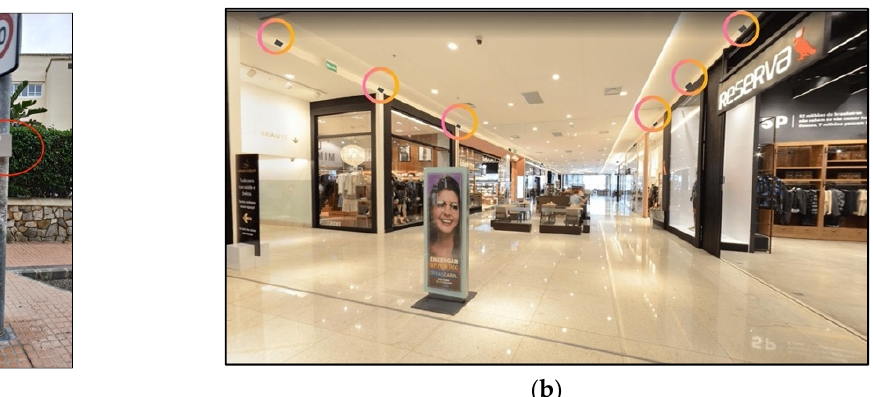
Figure 3. Example of the experimental tests before deployment; ( a ) outdoor; ( b ) indoor.